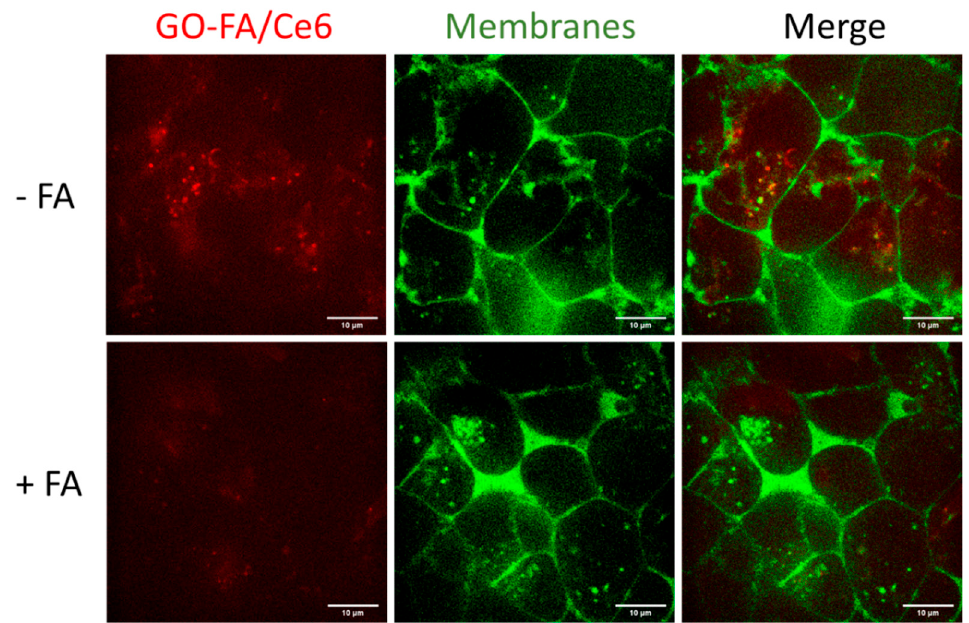
Figure 5. Confocal microscopy images of MCF-7 cells incubated with GO–FA/Ce6 for 8 h before or after FR saturation with free FA. In green, membranes stained with CellMask (excitation channel: 488 nm, emission: 500–550 nm); in red, GO–FA/Ce6.